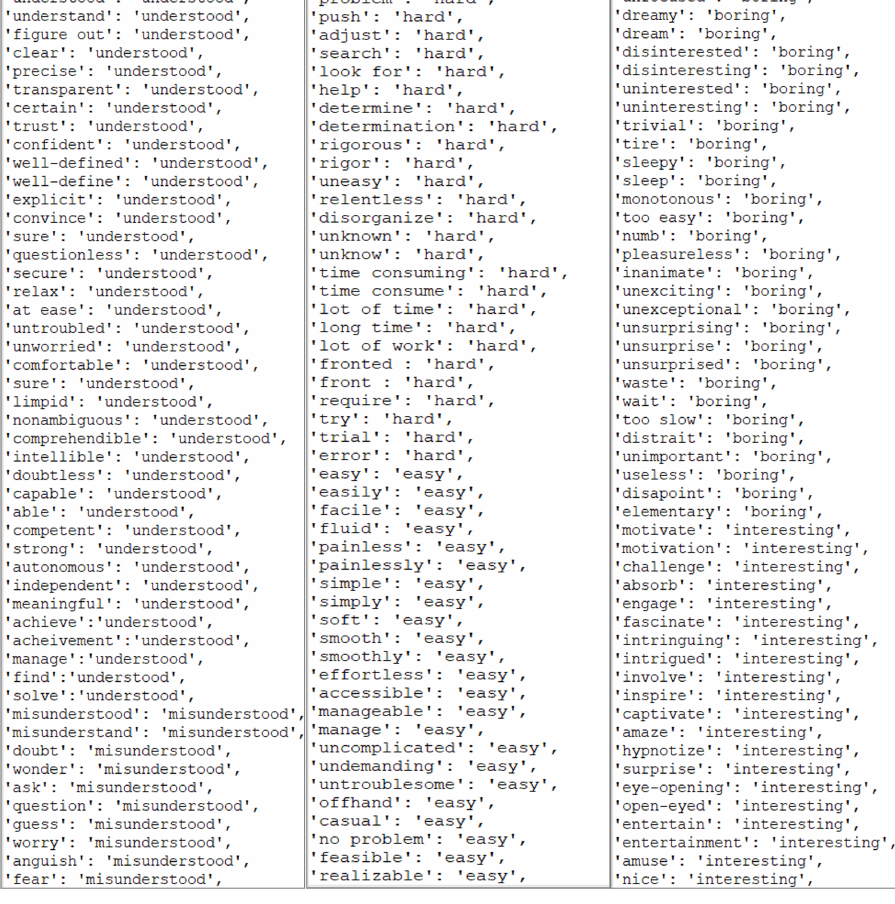
Figure 3. Customised hand-made emotions